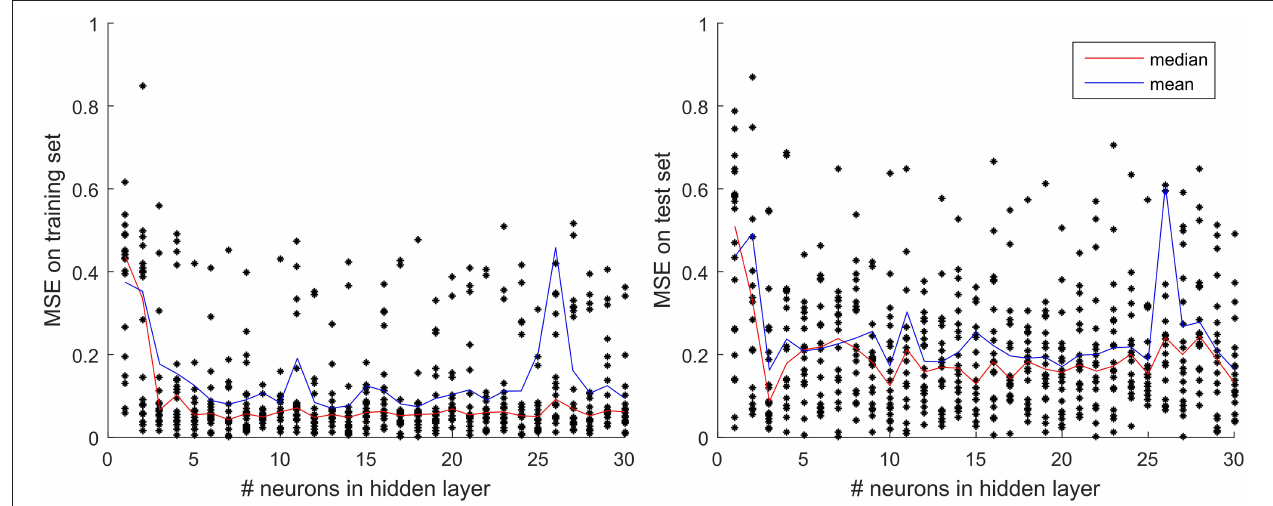
FIGURE 4 | Test and training set MSE as a function of the number of neurons in the hidden layer. The results displayed are the mean and median of 20 replicates performed for each number of neurons in the hidden layer, evaluated separately for the training set (Left panel) and the test set (Right panel) .